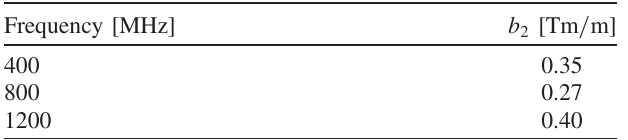
TABLE I. Required b 2 yielding the same stabilization as provided by LOs for HL-LHC at a chromaticity Q 0 x;y ¼ 10 [12]. Frequency